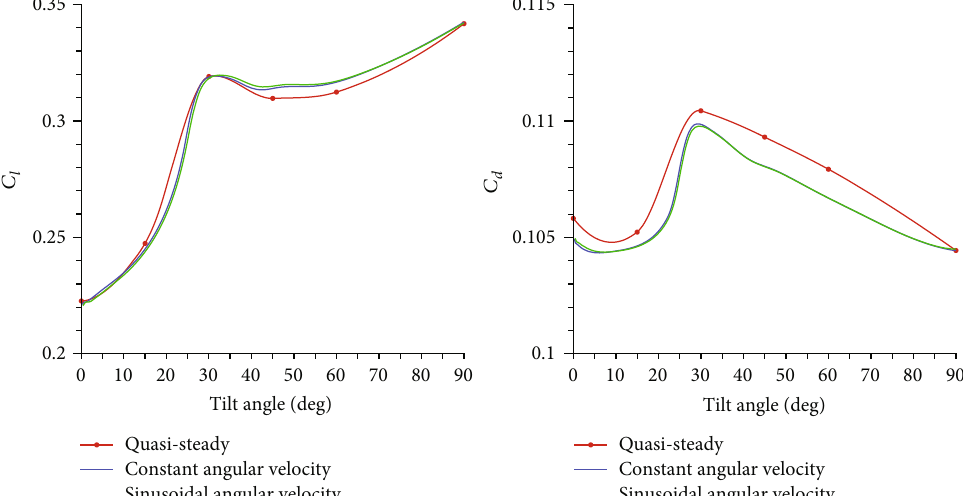
Figure 27: Unsteady lift and drag coe ffi cients for di ff erent conversion